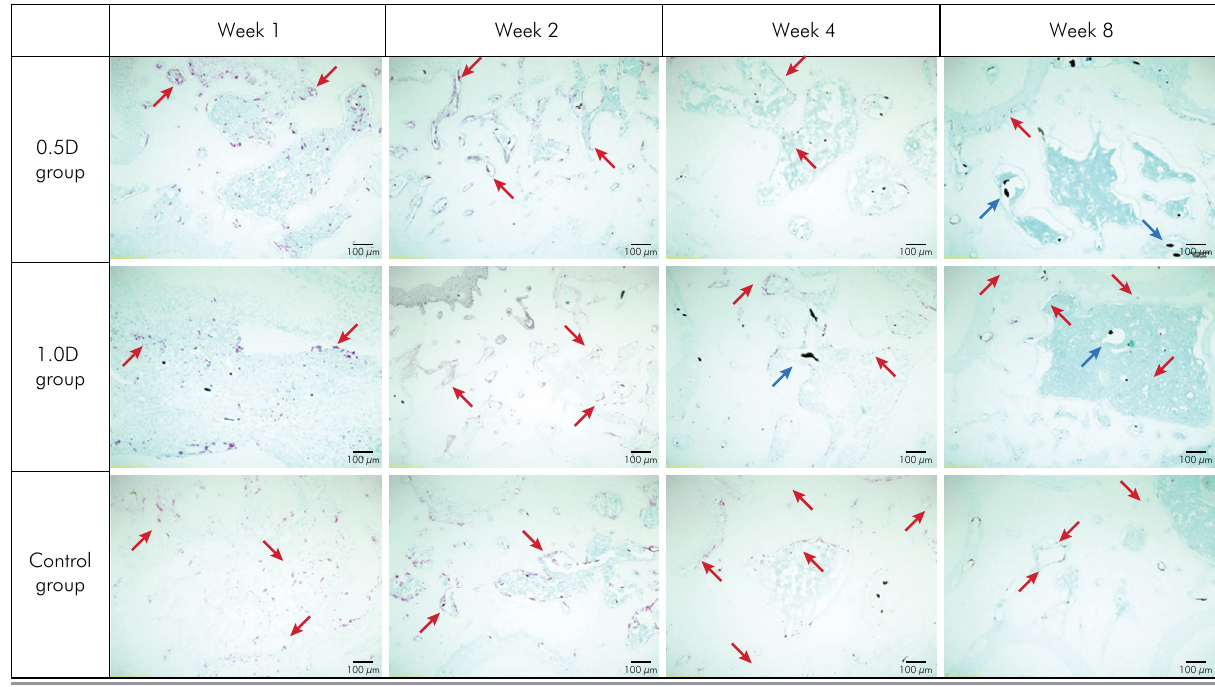
Figure 5. Changes in the TRAP-positive osteoclasts according to the time period after segmental osteotomy (1.0 mm displacement group). Red arrows, TRAP-positive osteoclasts; blue arrows, radiopaque silicone rubber in the blood